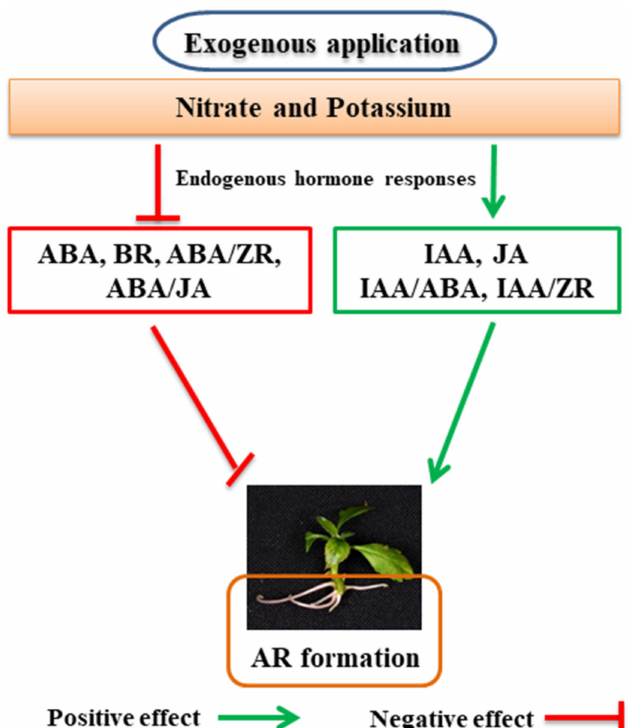
Figure 2. A suggested schematic diagram of how exogenous application of nitrate and potassium regulates different endogenous hormones during the formation of adventitious roots (ARs) in apples. Indole-3-acetic acid (IAA), zeatin ribosome (ZR), jasmonic acid (JA), abscisic acid (ABA), and brassi- nosteroid (BR). Ratios of hormone content, such as ABA/ZR, ABA/JA, IAA/ZR, and IAA/ABA. The green color shows a positive effect, and the red indicates a negative